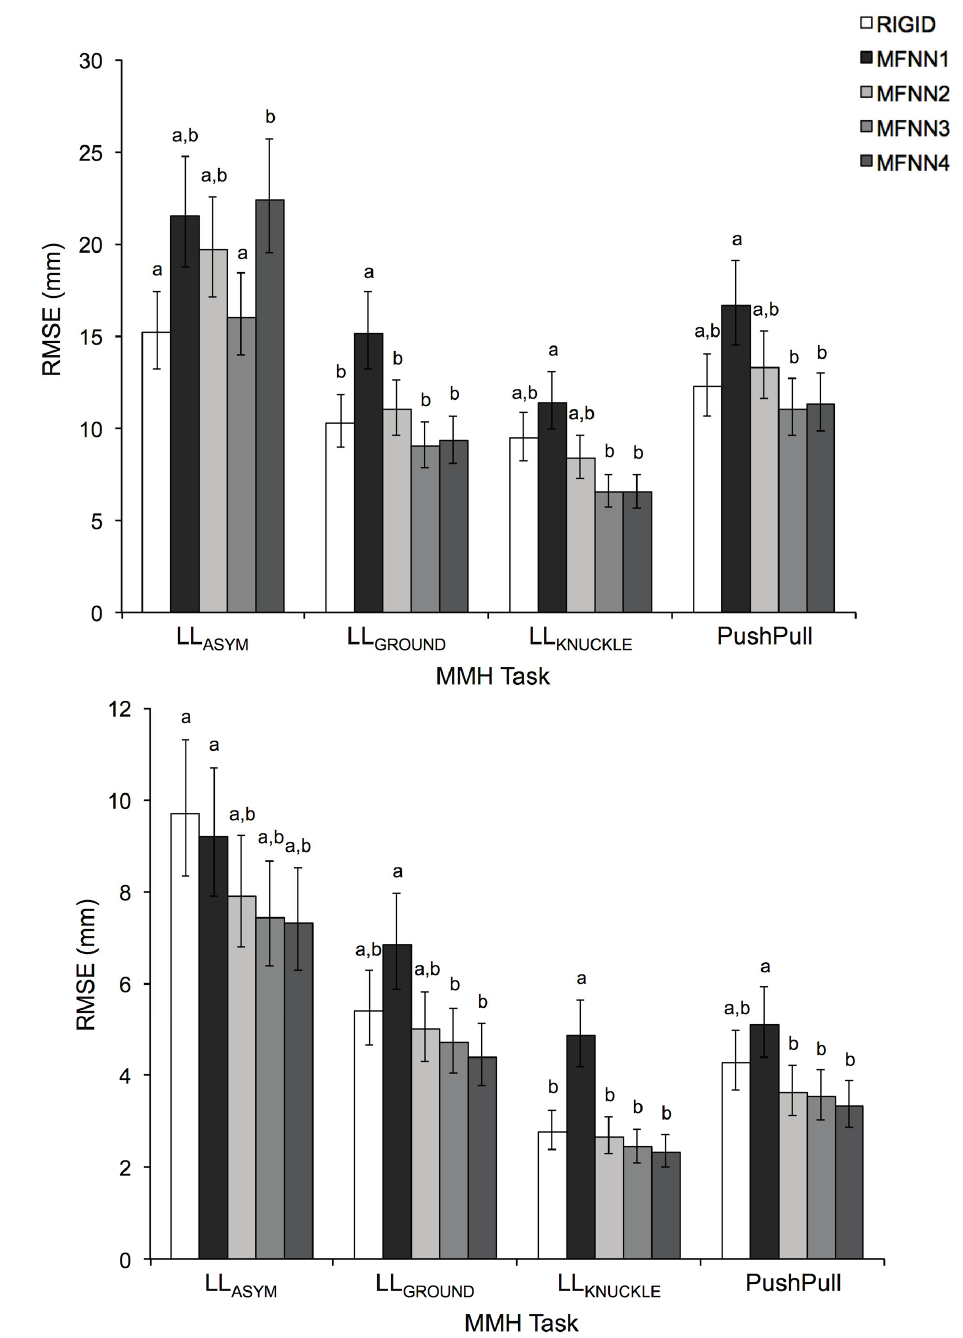
Figure 2. Root mean square errors (RMSE) in the anterio-posterior (AP: top ) and the medio-lateral (ML: bottom ) directions for each MMH task type, with respect to the different methods used for (cid:1794) (cid:2893)(cid:2924)(cid:2929)(cid:2925)(cid:2922)(cid:2915)(cid:2903)(cid:2918)(cid:2925)(cid:2915) . Note, see the methods section for detailed descriptions regarding the RIGID and MFNN1–4 methods. Pairs of values with different letters are significantly different within a given MMH task type, and error bars indicate 95% confidence